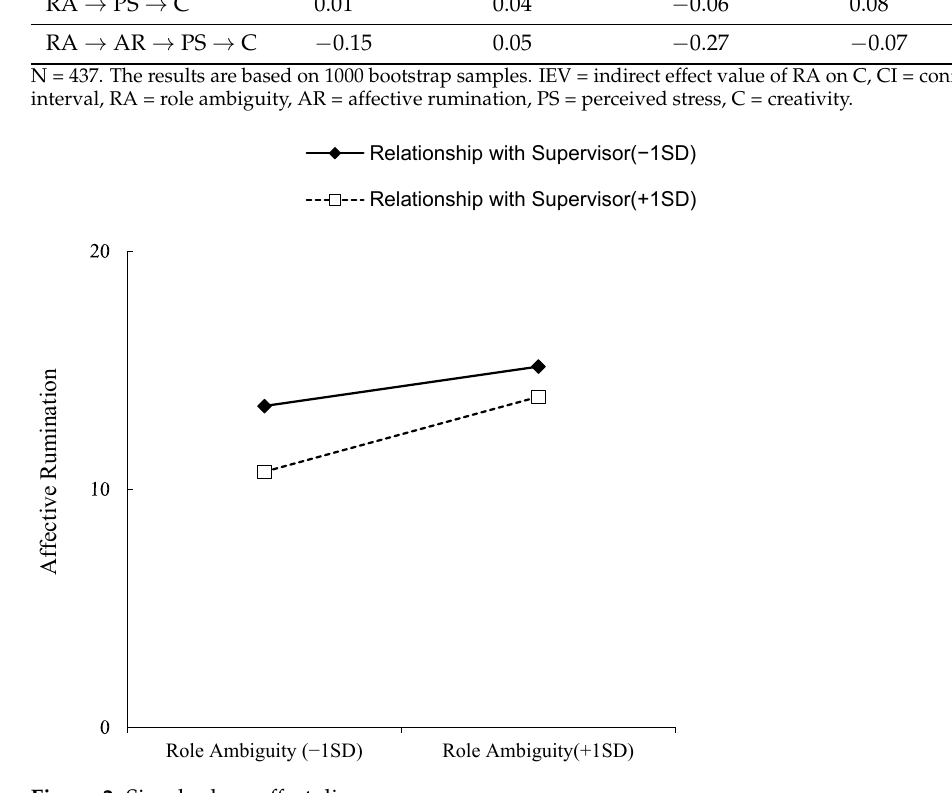
Figure 2. Simple slope effect diagram.